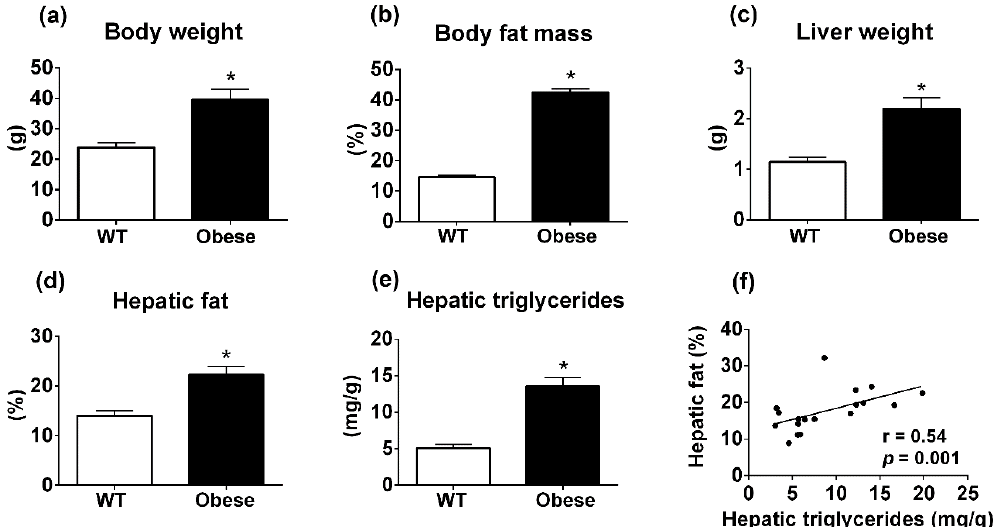
Figure 2. Metabolic parameters of wild-type or genetically obese Lep ob / ob and Lepr db / db mice. ( a ) Body weight (wild-type (WT), n = 10; Obese: Lep ob / ob , n = 6 and Lepr db / db , n = 2). ( b ) Body fat mass determined by TD-NMR. ( c ) Liver weight. ( d ) Percentage of hepatic fat measured by TD-NMR. ( e ) Hepatic TAG measured by calorimetric assay ( f ) Linear correlation between hepatic fat measured by TD-NMR and hepatic TAG determined by colorimetric assay. * p < 0.05 versus WT group (Student’s t -test).